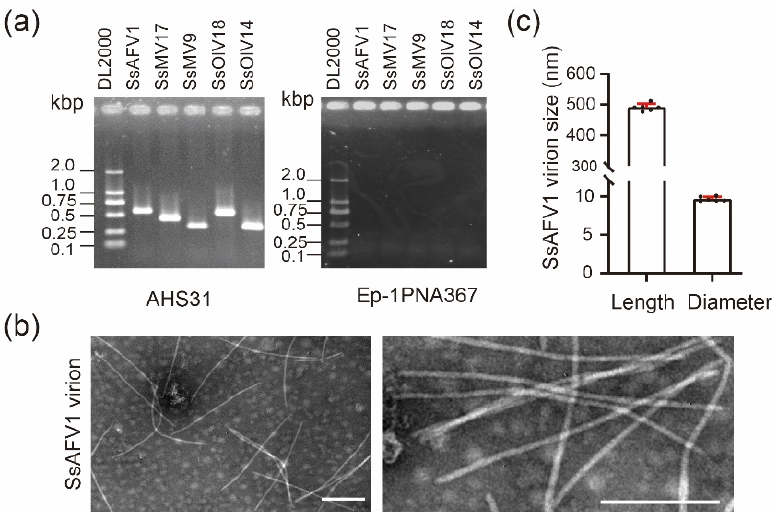
Figure 2. The viruses that infected the S. sclerotiorum strain, AHS31, and virions of SsAFV1. ( a ) Confirmation of the presence of five positive RNA viruses in strain AHS31 by RT–PCR. In control sets, ddH 2 O was used instead of RT products. Primers specific to each virus are listed in Table 1. ( b ) Virions of SsAFV1 observed under a transmission-electron microscope (TEM) after negative staining. The bar is 200 nm. ( c ) A histogram of SsAFV1 particle length and diameter. Error bars indicate standard deviation (SD) from sample means.